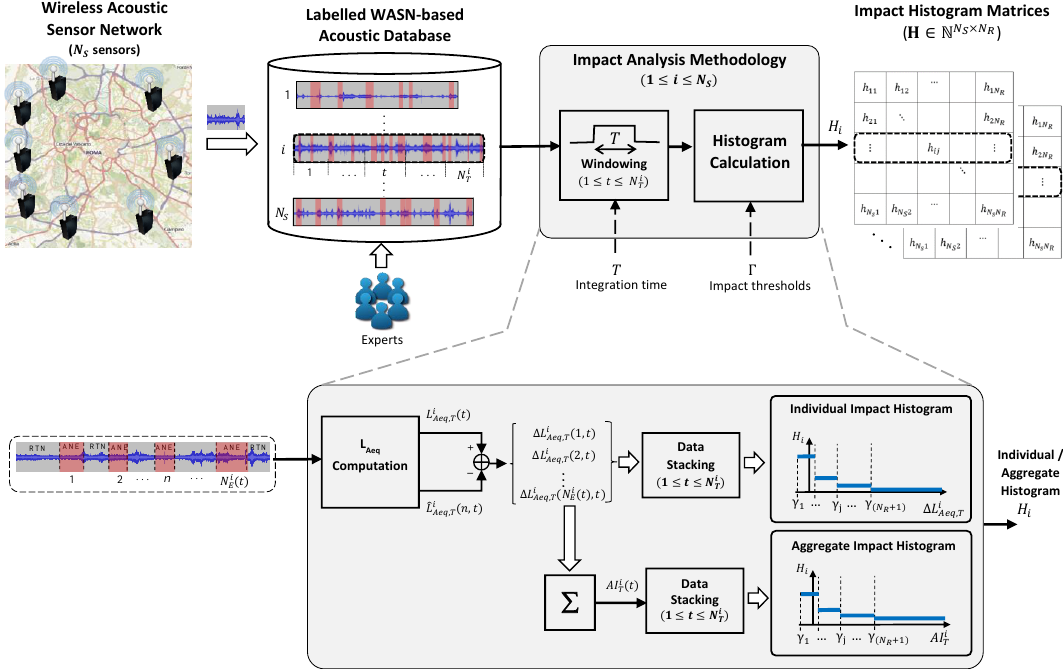
Figure 1. Block diagram of the impact analysis methodology on a labeled WASN-based acoustic dataset obtained from a N S sensors network, where T is the integration time considered to compute ( n , t ) for each sensor i and event n . Moreover, ∆ L i L i Aeq , T ( t ) and ˆ L i Aeq , T the individual and aggregate impacts of the ANEs, respectively. Finally, h ij represents the components of the histogram matrices H derived from the individual and aggregate impact histograms H i , which account for the impact values according to N R impact ranges defined by a set of impact thresholds Γ = { γ } 1 , γ 2 ,..., γ ( N R + 1 )